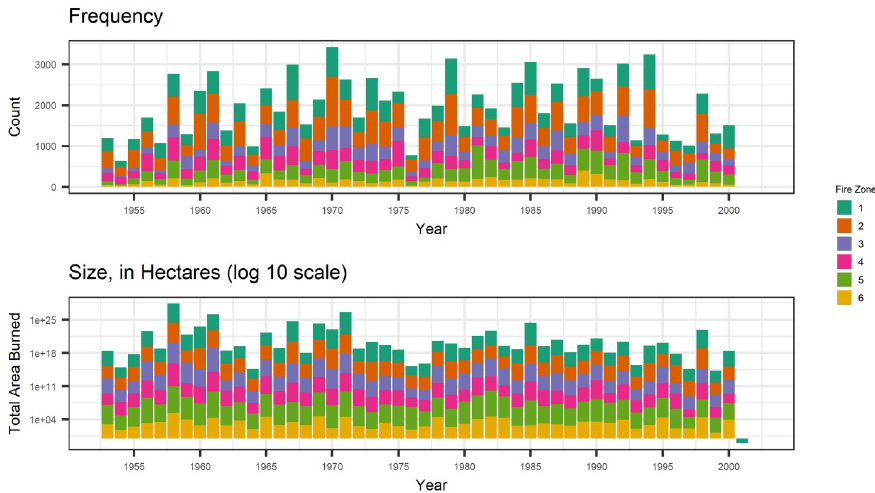
Fig 1. The number and size of fires in each zone, coloured by fire zone. The number of fires is equally distributed across regions, but region 5 tends to have much larger fires than the other